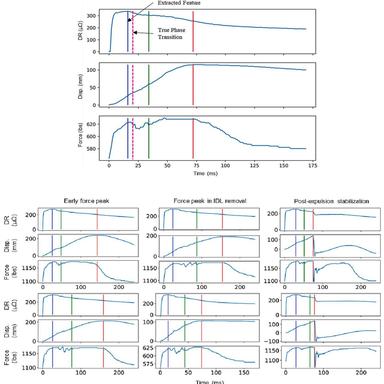
Detected phase transition points and true transition from Phase 1 to 2 (dotted magenta line). (For interpretation of the references to color in this figure legend, the reader is referred to the web version of this article.)